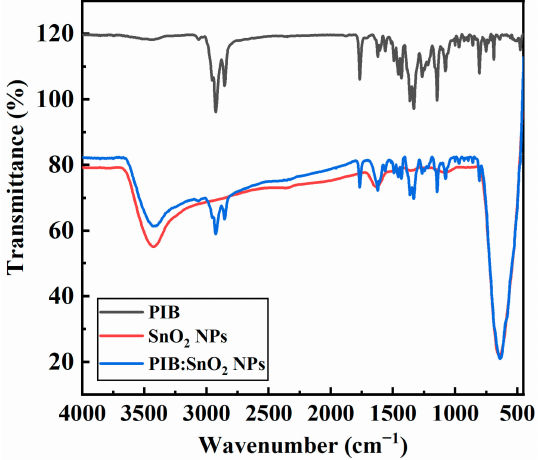
Figure 1. Infrared spectra of PIB and PIB: SnO 2